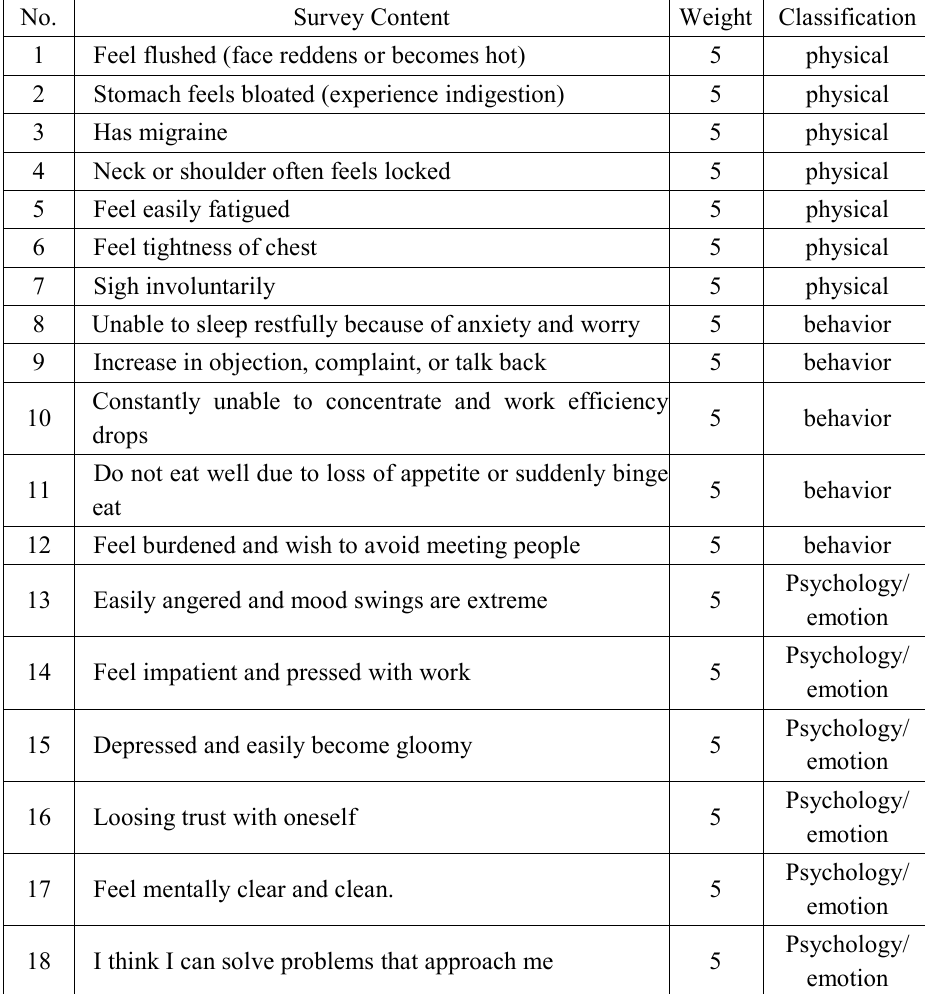
Table 4 Questionnaire items used in stress